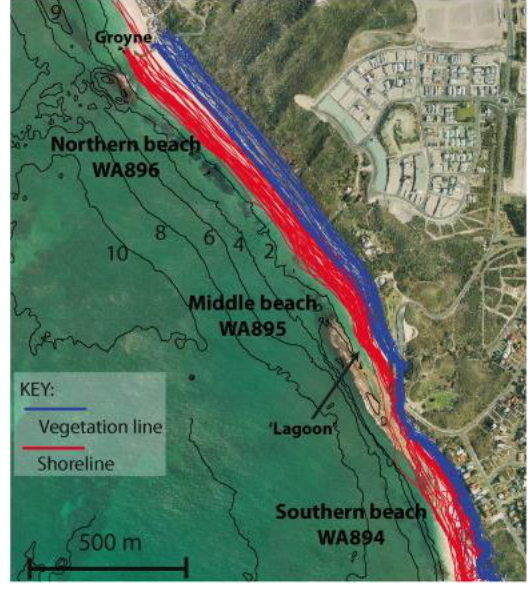
Fig. 1: Vegetation lines and shore lines from 1974 to 2008, source: Gallop et al. (2015) Studies Misra and Balaji (2015); Adarsa et al. (2015) and Nandi et al. (2015) used Digital Shoreline Analysis System (DSAS) for detection of changes of shoreline in a monitored area. DSAS is a special extension which is focused on shoreline analysis. This software can calculate the rate of shoreline change. Example from this study is available in Figure 2.